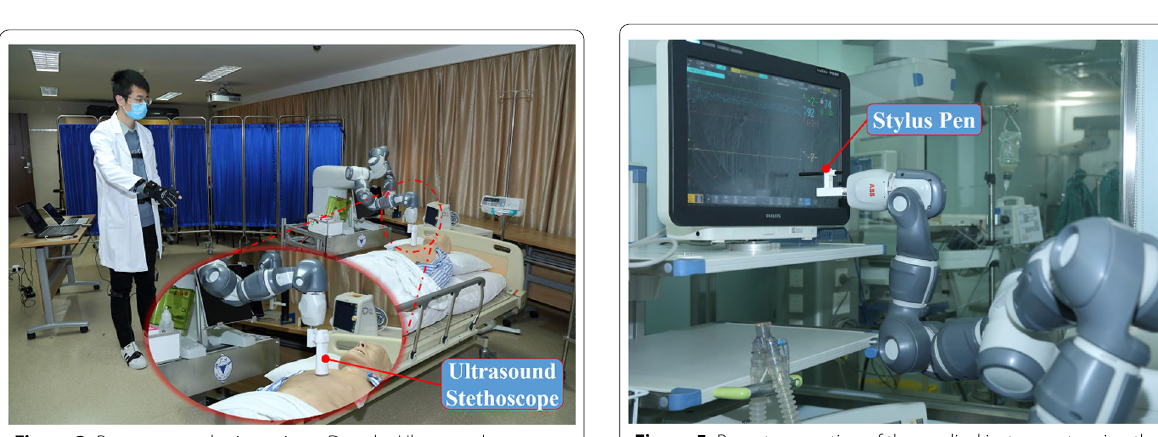
Figure 3 Remote auscultation using a Doppler Ultrasound Stethoscope based on the teleoperated robot